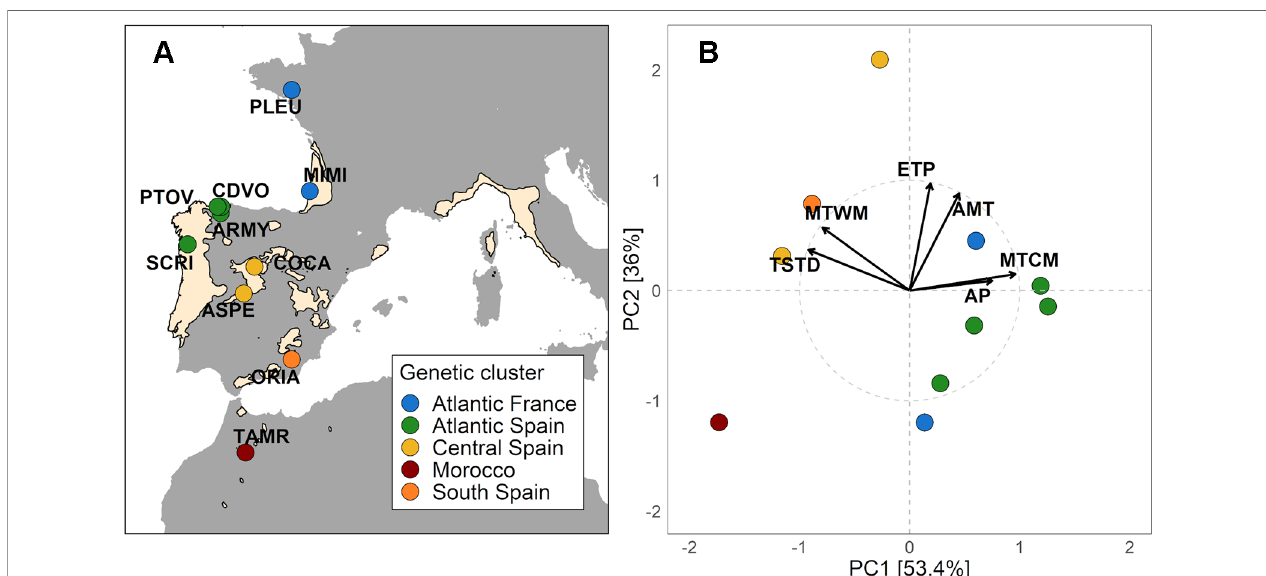
FIGURE 1 | (A) Distribution map of Pinus pinaster (from EUFORGEN 2009, www.euforgen.org) showing the location of the 10 studied population (See Table S1 ). Colors indicate populations from different genetic clusters based on 1745 SNPs genotyped in 153 randomly sampled and unrelated individuals (from Jaramillo- Correa et al., 2015). (B) Principal component analysis of climate variables and plot of the 10 populations in the principal components ordination space. The climate variables included were annual mean temperature (AMT), maximum temperature of the warmest month (MTWM), minimum temperature of the coldest month (MTCM), temperature seasonality (TS), annual precipitation (AP), and potential evapotranspiration (ETP). Higher values of PC1 were indicative of Atlantic climates with higher precipitation and lower thermic oscillation, while lower values were related to Mediterranean climates. PC2 was positively associated with annual mean temperature (AMT) and potential evapotranspiration